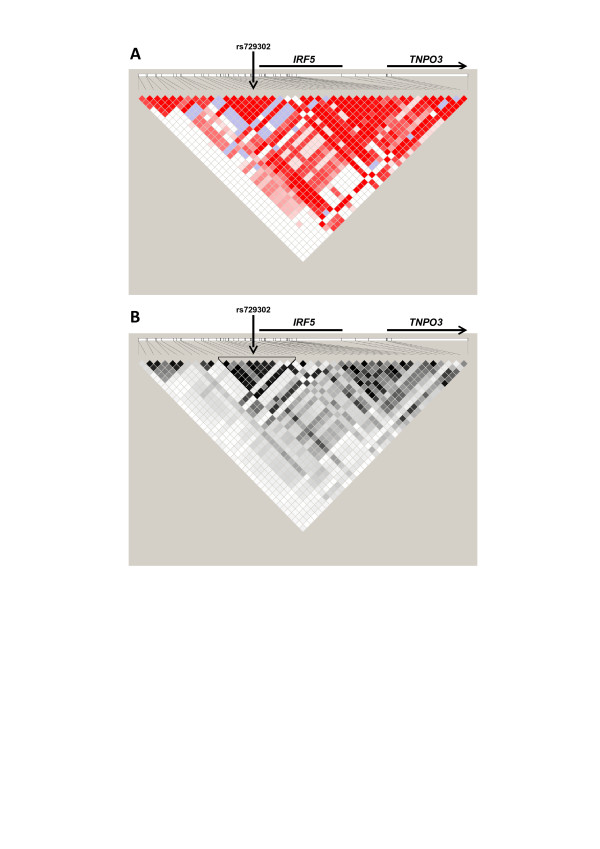
IRF5 linkage disequilibrium maps. Pairwise D' (A) and r2 (B) between 44 polymorphisms in the IRF5 locus obtained in 95 Spanish healthy controls are represented. Ten additional single-nucleotide polymorphisms (SNPs) were excluded because of low minor allele frequency (<2%) or complete redundancy with other SNPs (see Results). Color scale from white to red indicates D' values from 0 to 1 in (A) and that from white to black indicates r2 values from 0 to 1 in (B). The triangle in (B) surrounds the block containing SNPs in tight linkage disequilibrium with rs729302. Positions of the coding sequences of IRF5 and TNPO3 are signaled.